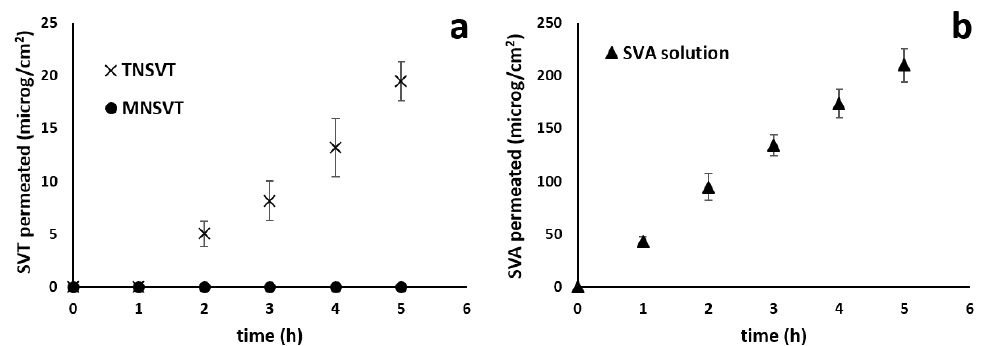
Figure 2. Trans-conjunctival permeation profiles of SVT from micelles (SVT 1 mg/mL; panel a ) and SVA from 1 mg/mL saline solution (panel b ).